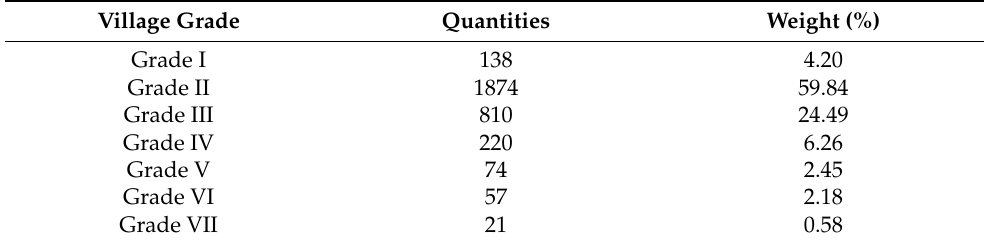
Table 7. The quantities and weight of grades of